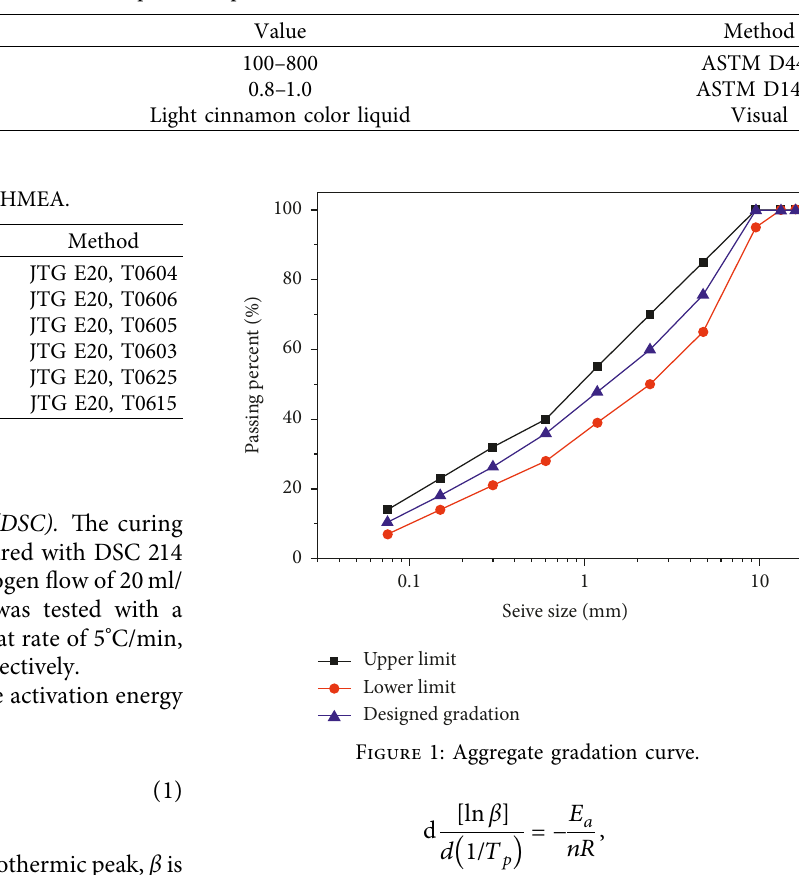
Table 4: Properties of part B in HMEA.